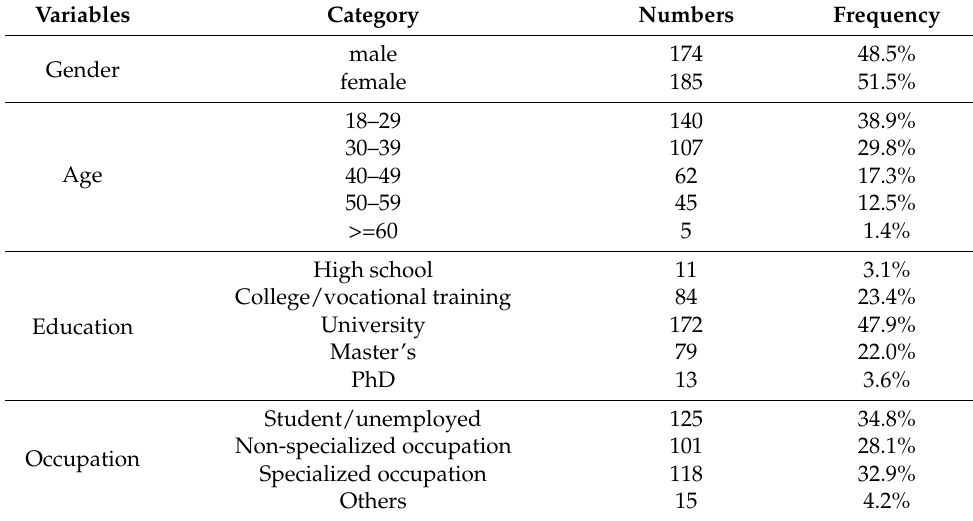
Table 2. The demographic profile of respondents.